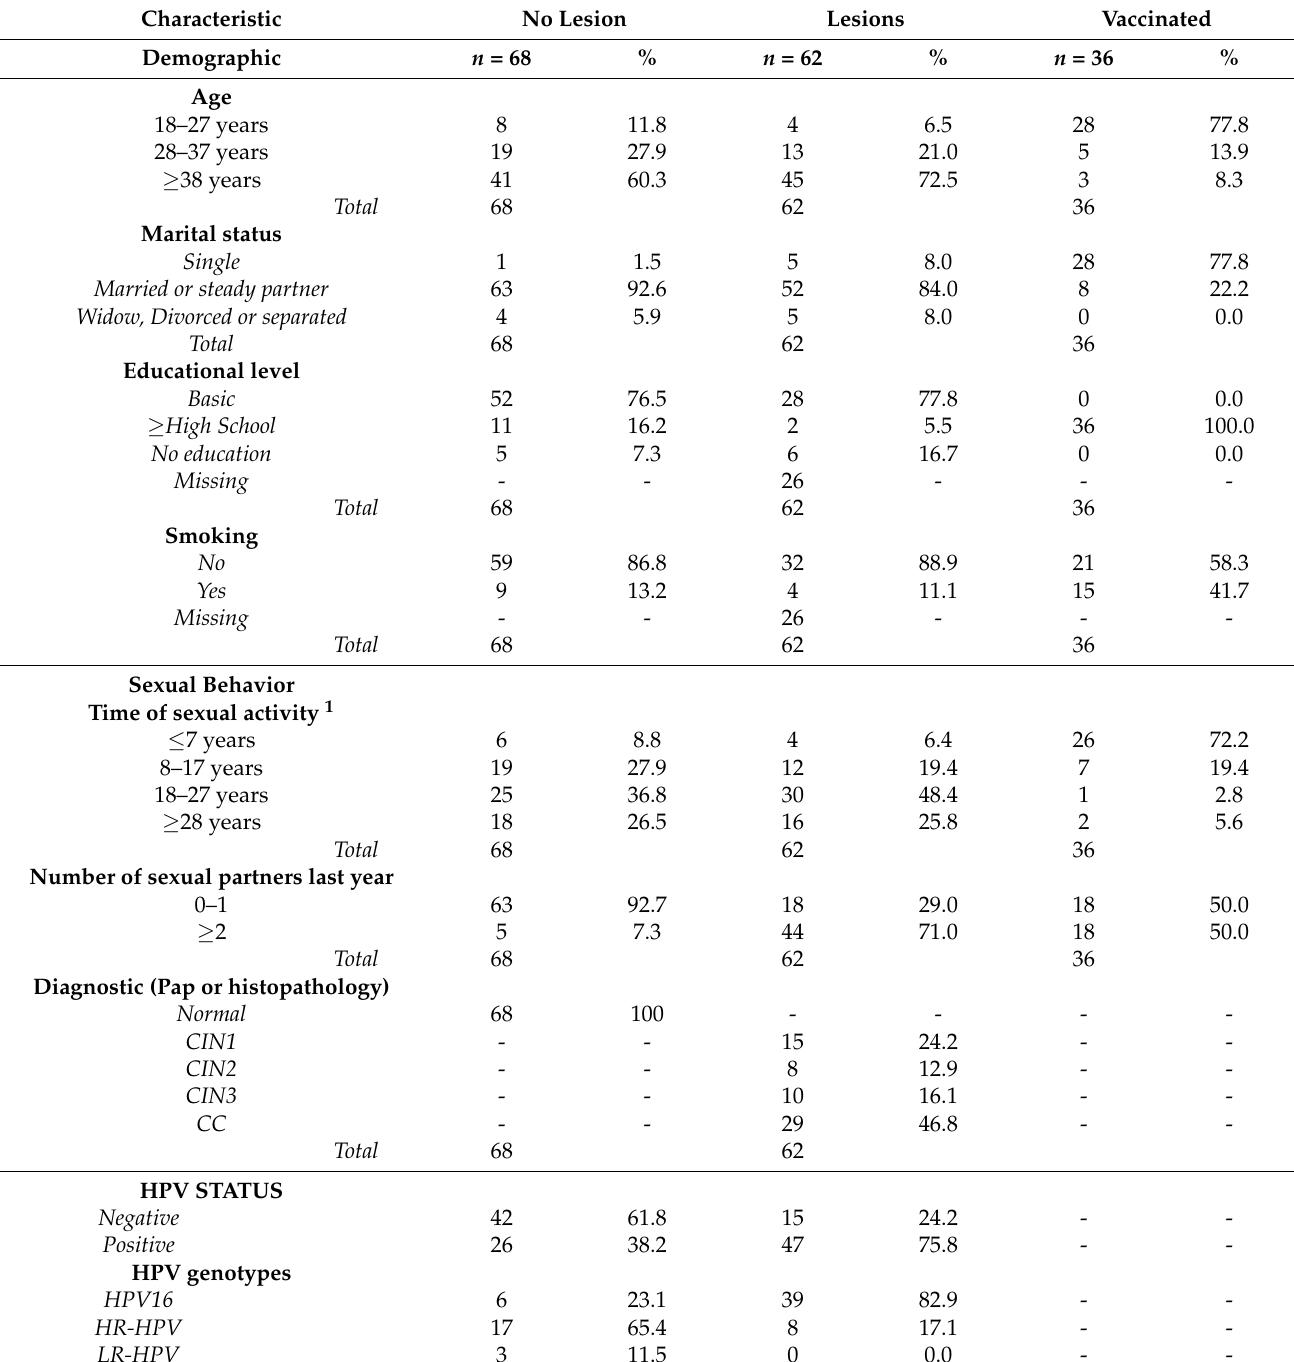
Table 1. Demographic and sexual behavior characteristics of the study